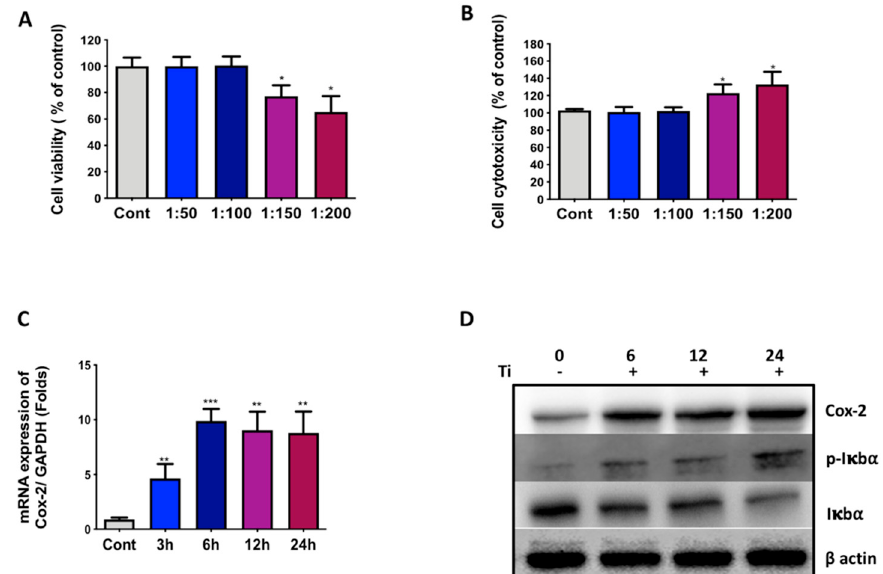
Figure 1. Ti particle e ff ects on SW982 cell line. Ti particles were treated with SW982 cells for 24 h in a dose-dependent manner (cell-to-particle ratios of 1:50, 1:100, 1:150, and 1:200). The control (Cont.) group was treated with PBS only. Cell viability and cell cytotoxicity were analyzed by ( A ) MTT and ( B ) LDH activity assay, respectively. ( C ) RT-PCR analysis after the treatment with Ti particles (cell-to-particle ratio of 1:100) of SW982 at di ff erent time points (0 to 24 h) displayed an increase in the mRNA expression level of Cox-2. ( D ) Quantification of protein by Western blotting after 0, 6, 12, and 24 h of Ti particle treatment (cell-to-particle ratio of 1:100) of SW982 cells showed increased expression levels of Cox-2 and p-I κ b α . At the same time, an instability of I κ b α was observed. The results are demonstrated as means ± standard deviations (SDs) of three di ff erent independent experiments. Note: * p < 0.05, ** p < 0.01, and *** p < 0.001 indicate significant di ff erences from the control group.